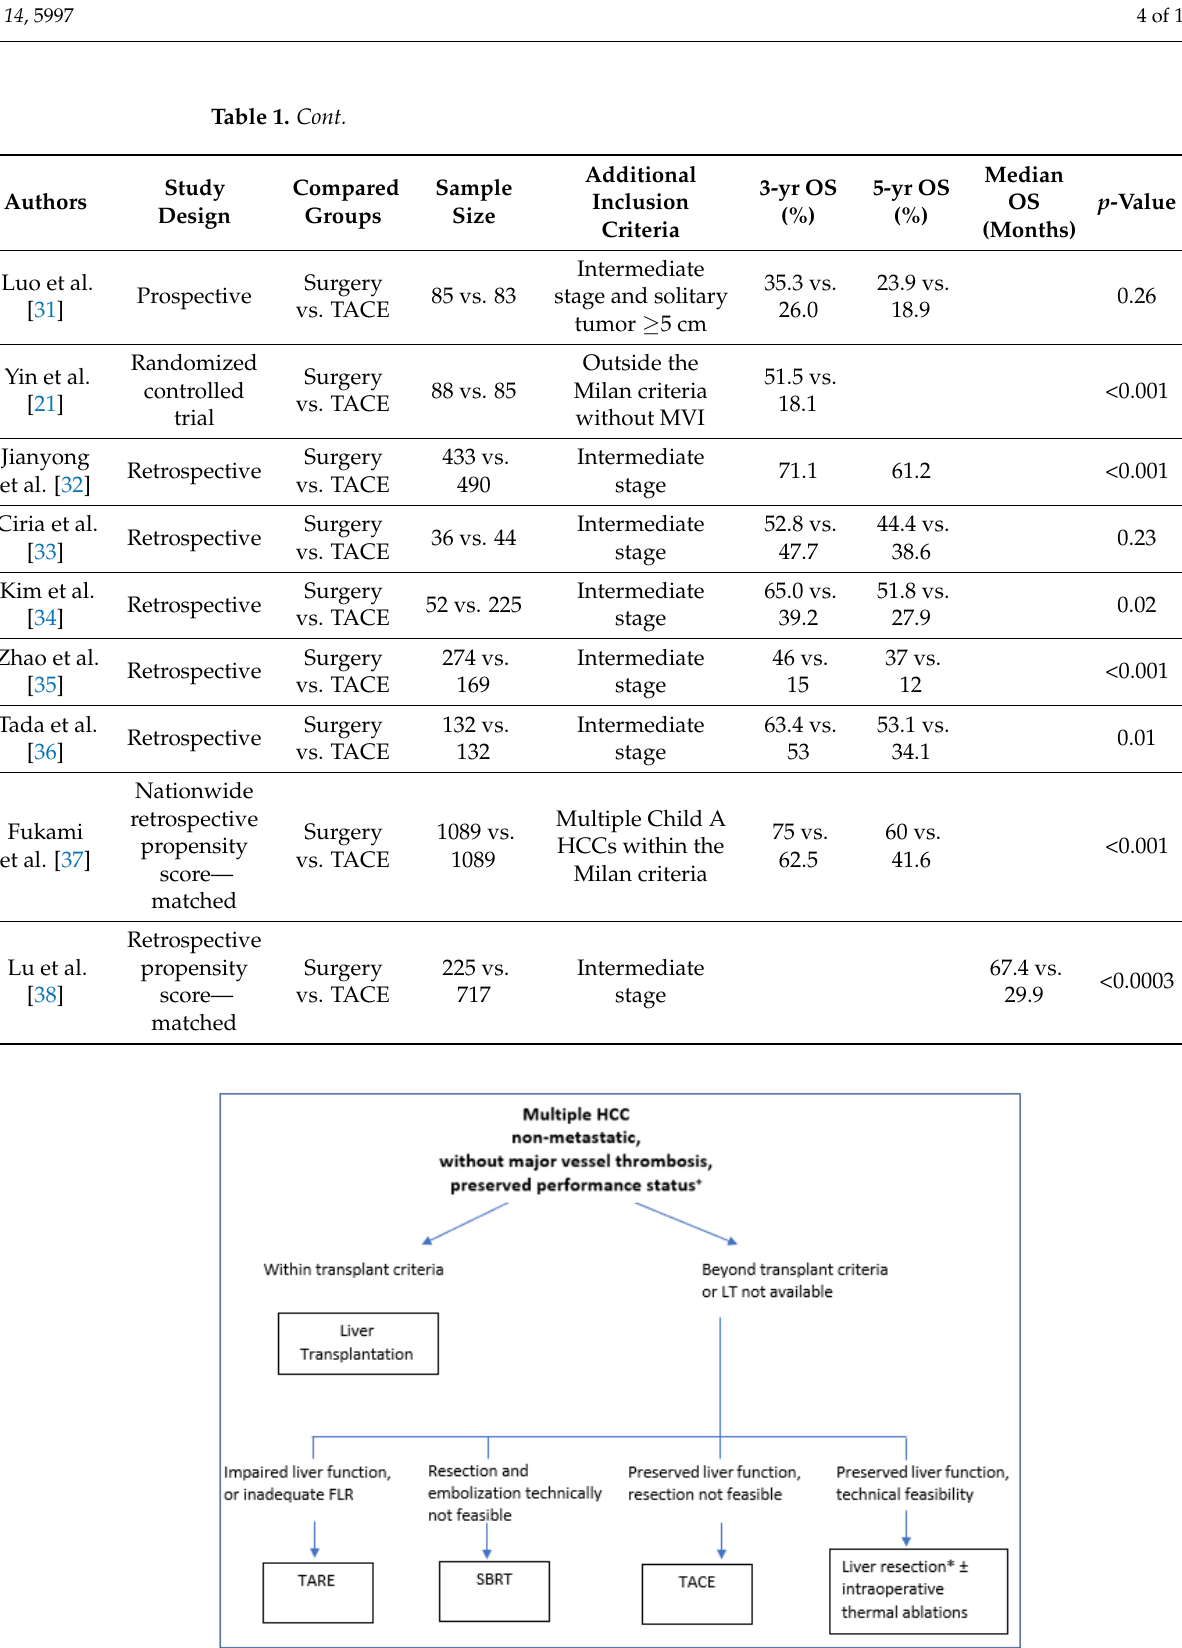
Figure 1. Proposed treatment algorithm for multiple non-metastatic HCC. + All patients need to be evaluated and discussed in a multidisciplinary team approach, and treatment must be tailored to every specific case. * Laparoscopic approaches should be preferred in centers with adequate expertise and in cirrhotic patients. FLR: future liver remnant; SBRT: stereotactic body radiation therapy; TARE: Table 1. Studies comparing Surgery and TACE in BCLC-B patients. OS: overall survival; TACE: trans-arterial chemoembolization; HCC: hepatocellular carcinoma; BCLC: Barcelona clinic liver can- cer.